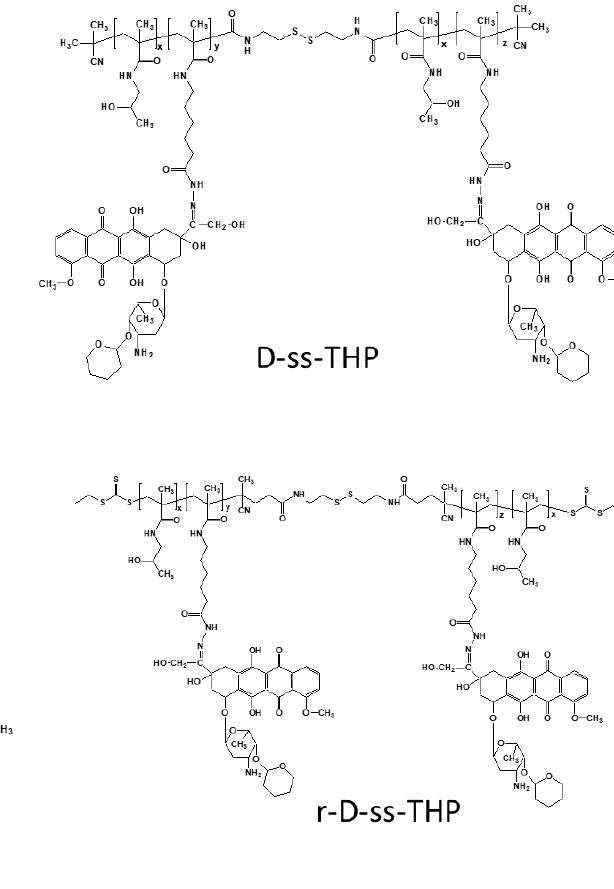
Figure 2. Structures of polymer conjugates. Table 1. Characteristics of the polymer precursors and